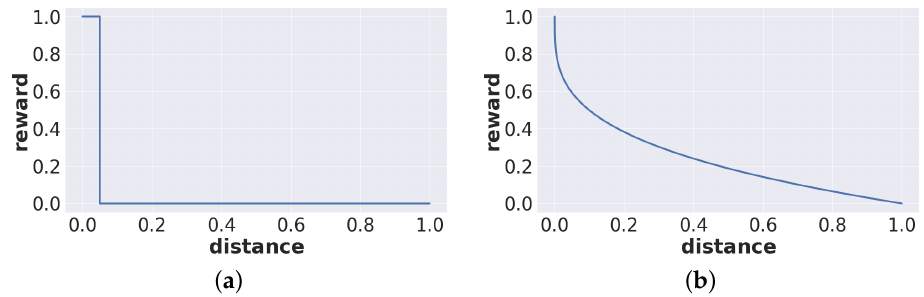
Figure 8. Reward shaping: ( a ) sparse reward function; ( b ) shaped reward